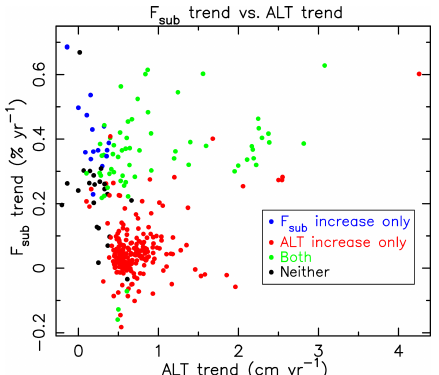
Figure 10. Increase in annual F sub (%yr − 1 ) vs. increase in seasonal maximum ALT (cmyr − 1 ) for all 312 domain grid cells. Relevant statistics are listed in Table